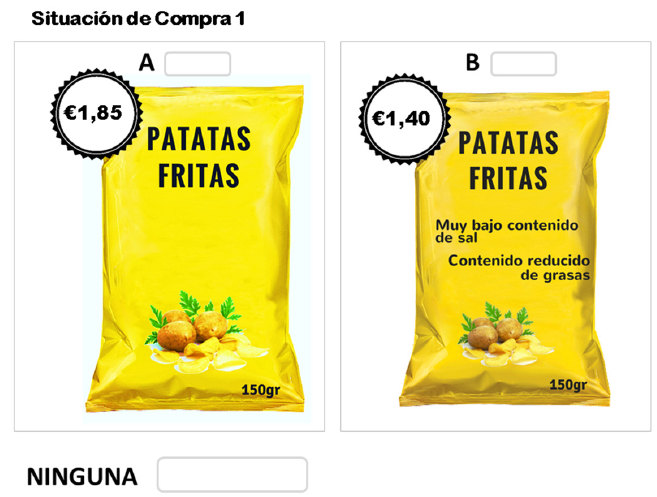
Figure 1. Example of a choice set.